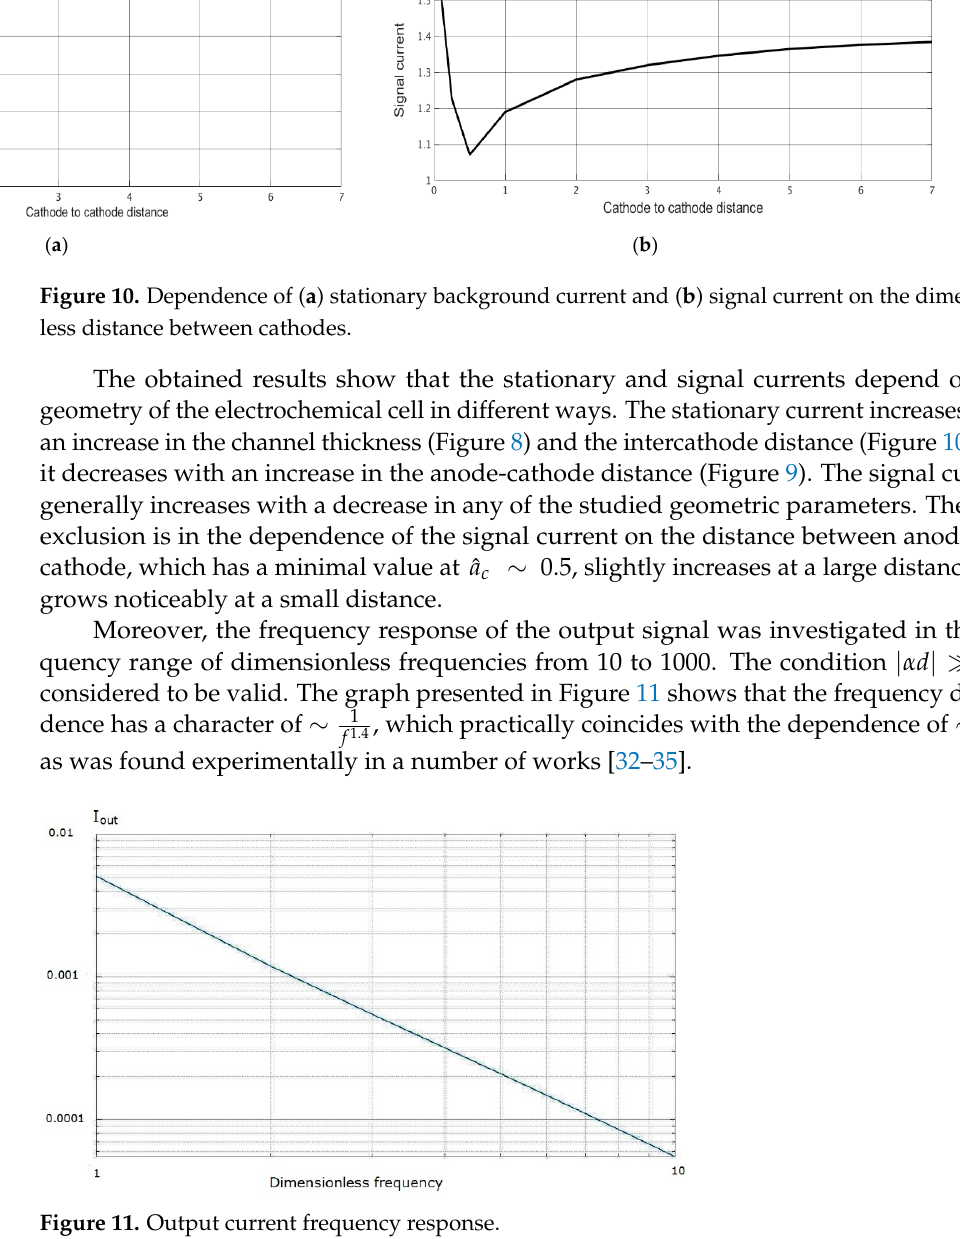
Figure 11. Output current frequency